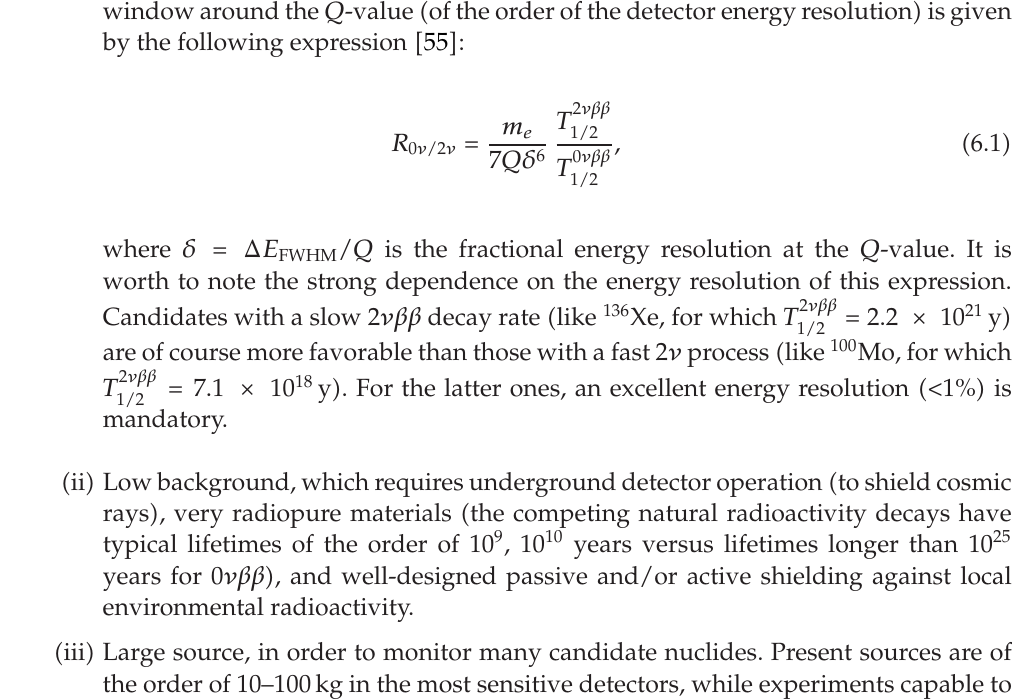
and initial momentum, or, in one proposed approach, the species of the daughter nucleus. The desirable features of this nuclear detector are as